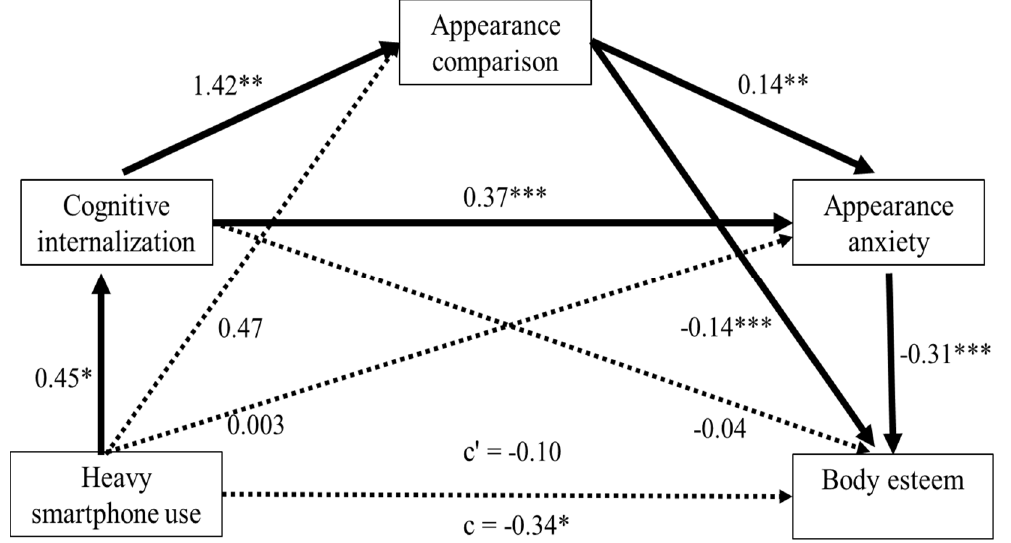
Figure 2. A mediational model predicting body esteem from excessive smartphone use (more than 4 h daily), relative to the reference (less than 1 h) via cognitive internalization, engagement in appearance comparisons, and social appearance anxiety as serial mediators. c’ represents the relative direct effect of heavy smartphone screen time on body esteem without controlling for social media usage, and c signifies relative total effect. All values represent standardized regression coefficients. *